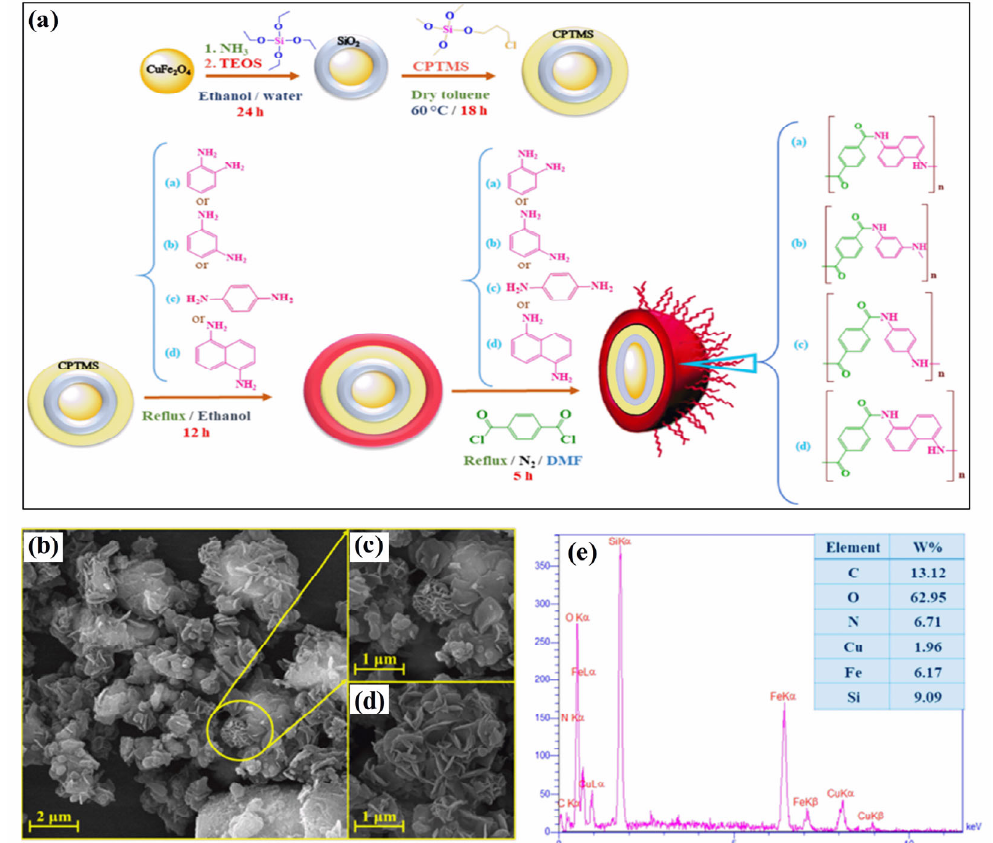
Figure 1. ( a ) Schematic diagram of the formation of CuFe 2 O 4 @SiO 2 ‐ poly(m ‐ phenylene tereph